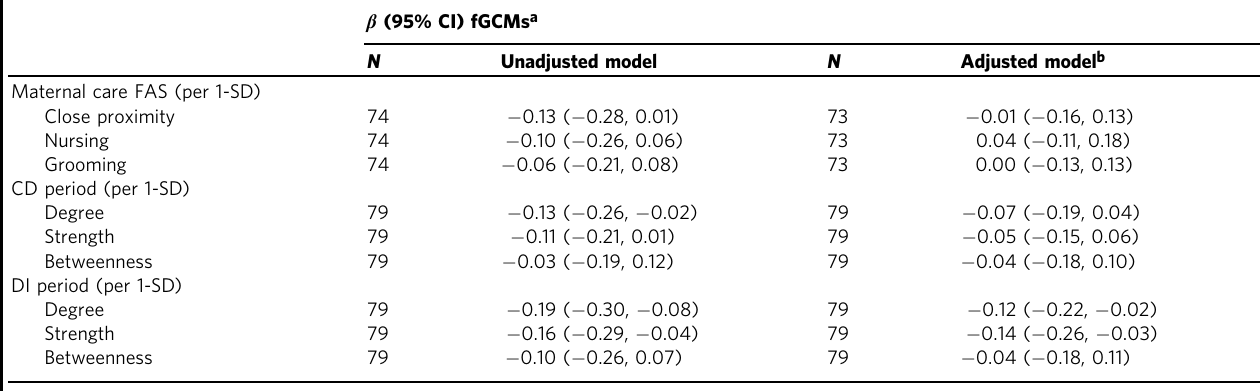
Table 1 Association of maternal care and early-life social network metrics with adult fGCMs.